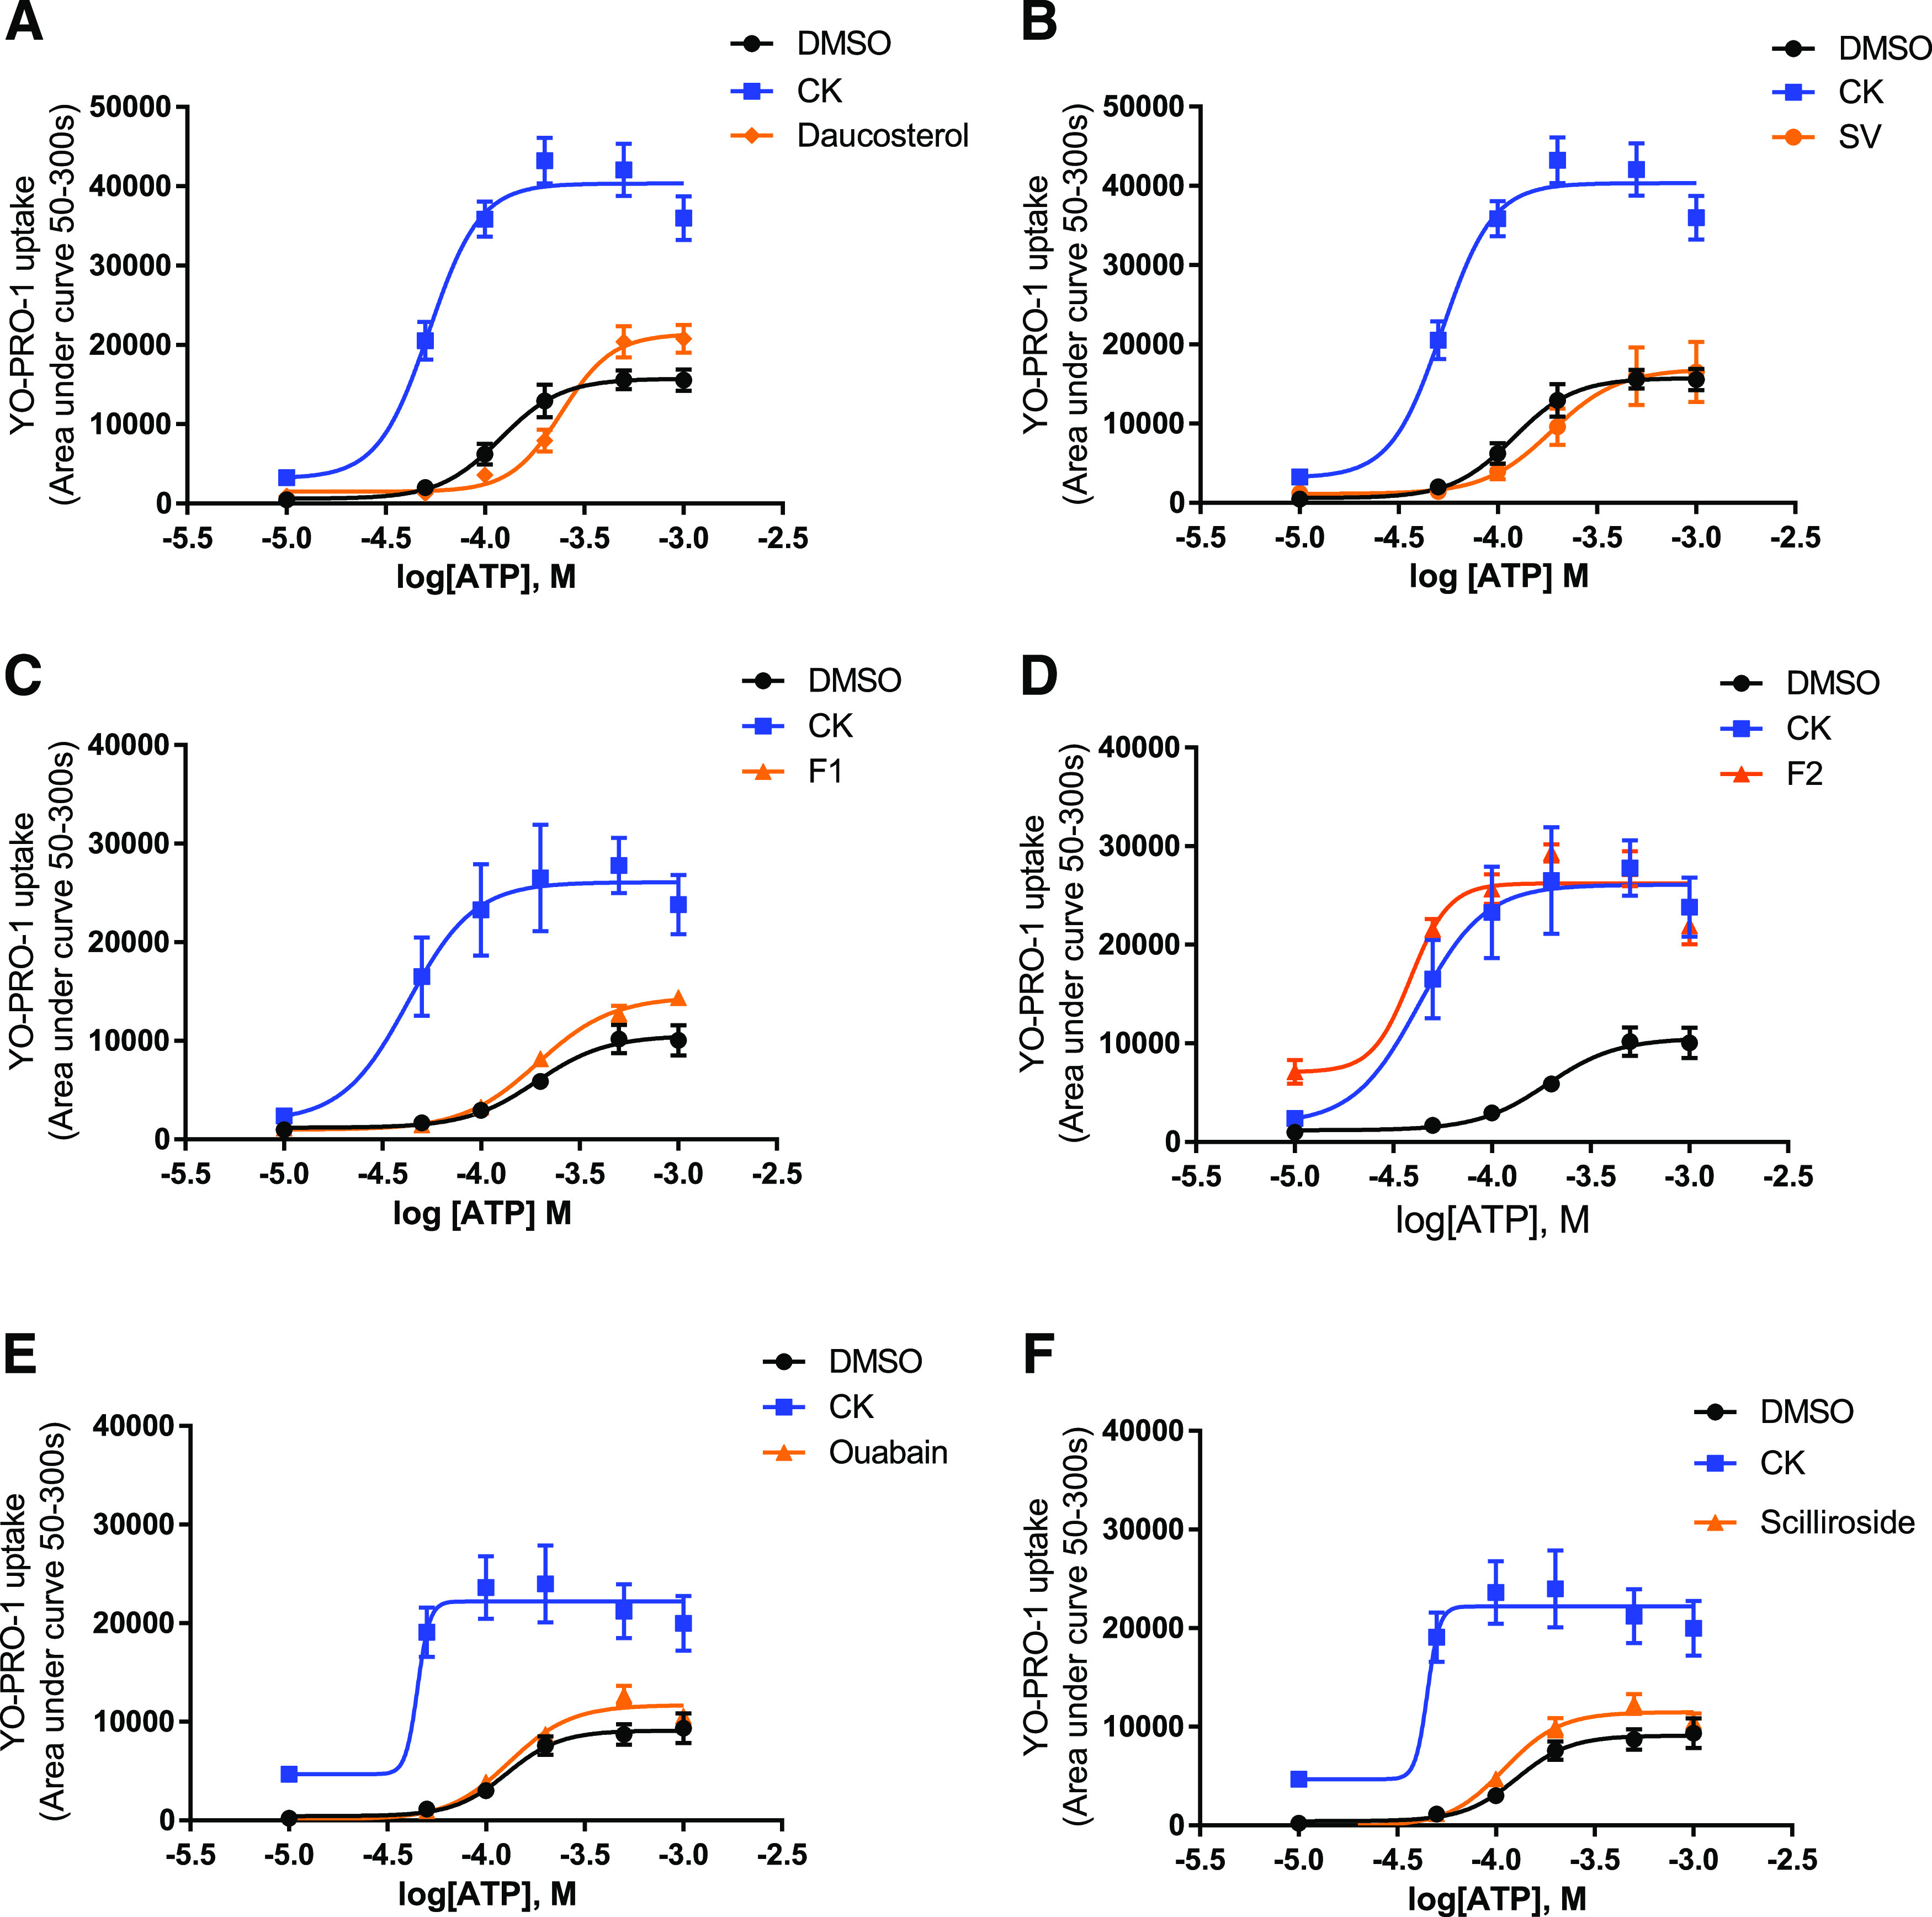
Screening glycosides containing monosaccharide moieties at P2X7. Dose-response curves to ATP in the presence of vehicle (DMSO), ginsenoside-CK, and the following: daucosterol (10 µM) (A), stevioside (SV; 10 µM) (B), ginsenoside-F1 (F1; 10 µM) (C), ginsenoside-F2 (F2; 10 µM) (D), ouabain (10 µM) (E), or scilliroside (10 µM) (F). Ginsenoside-CK is demonstrated throughout as the reference compound (same data shown in each plot). Data are collated from three independent experiments each performed in triplicate. Error bars represent S.D.